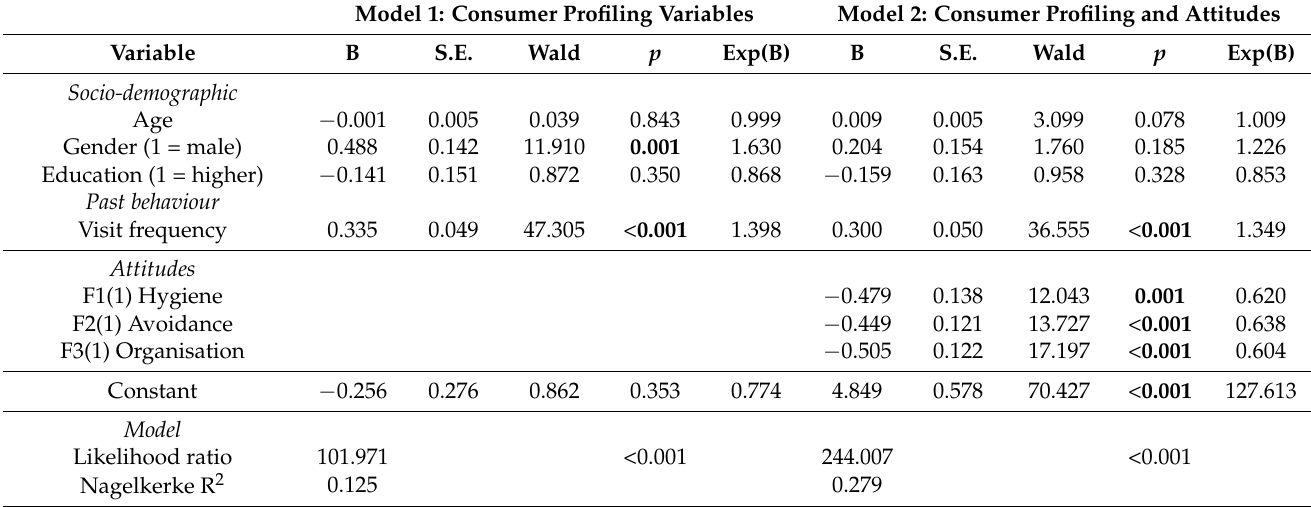
Table 4. Coefficient estimates and diagnostics from hierarchical binary logistic regression